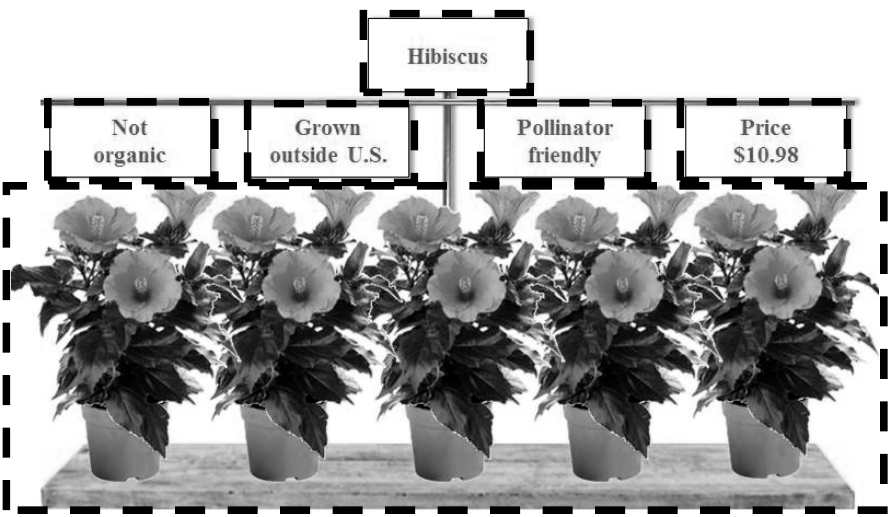
Figure 4. Designated areas of interest (indicated by the dashed lines) around the product image and attribute signs.